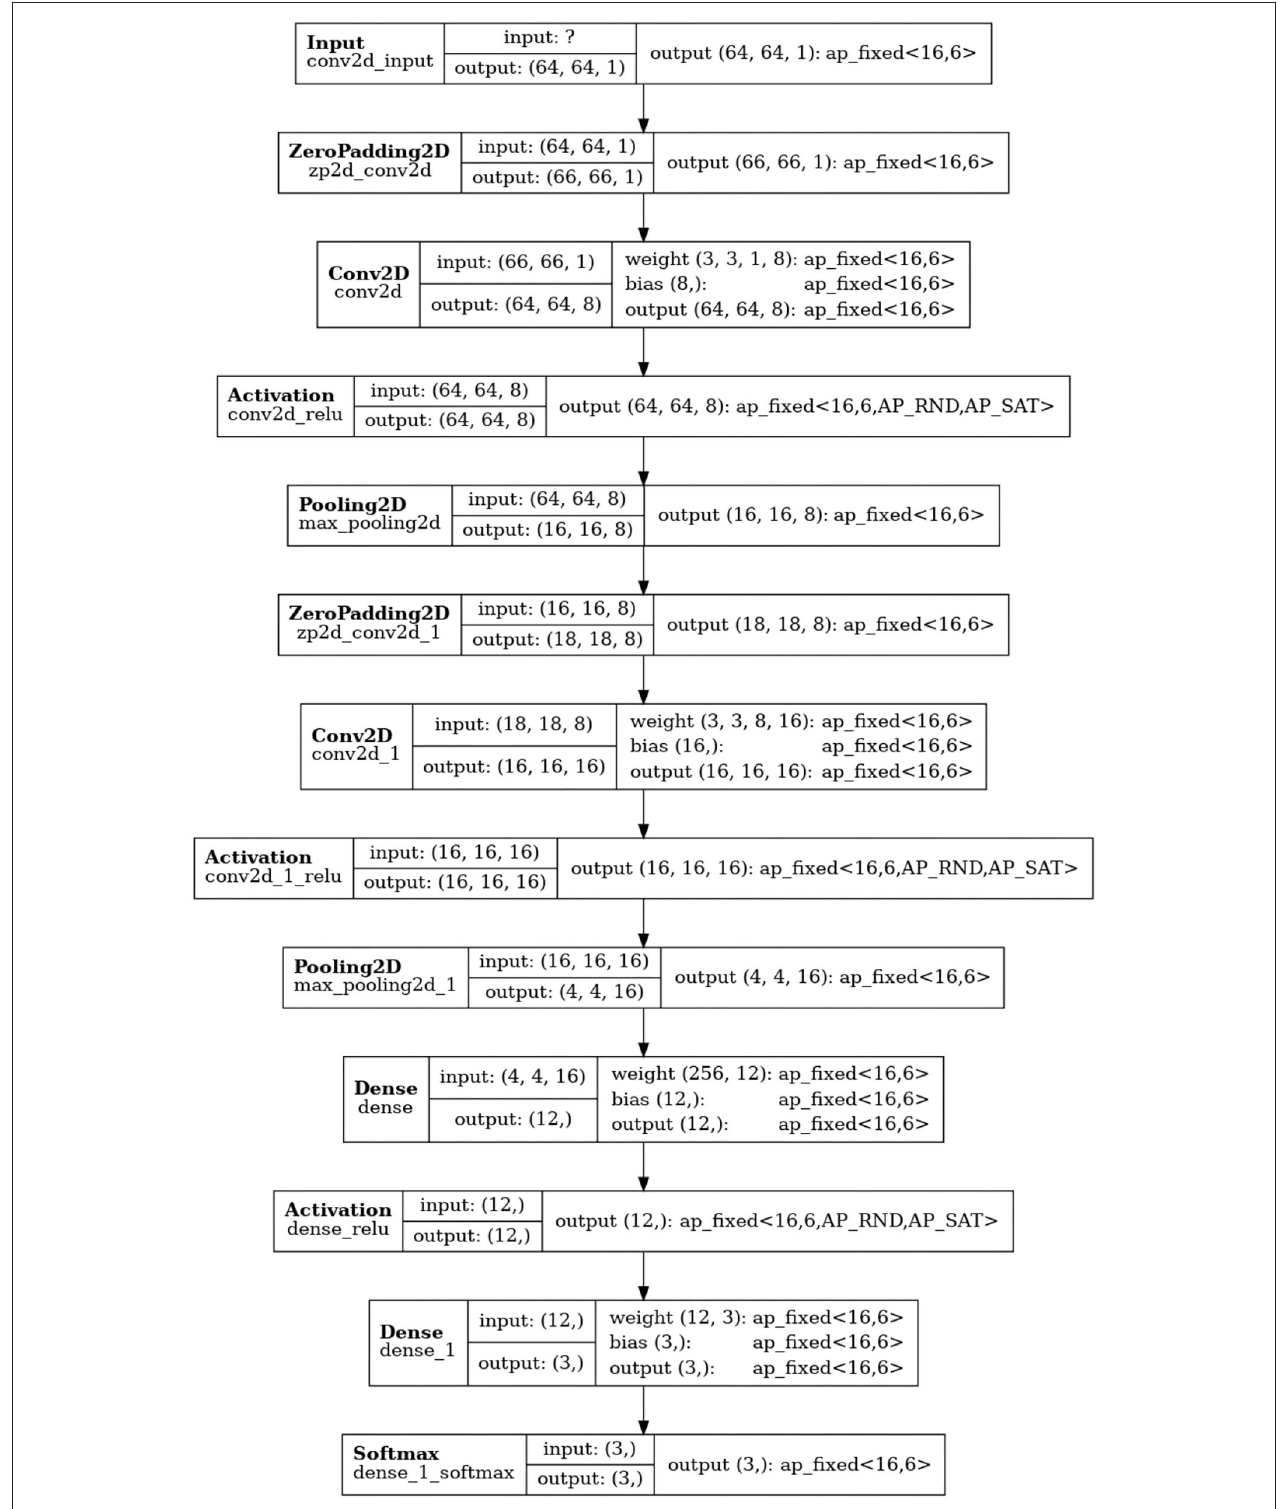
FIGURE 7 | Precision configuration of layers in the reference CNN02-DS-OP .